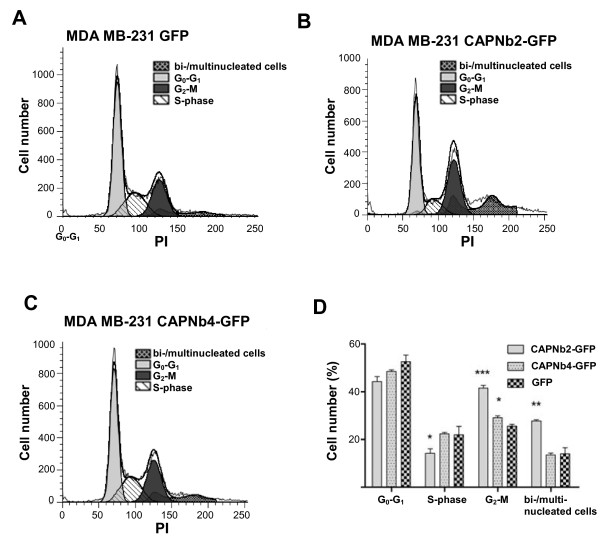
CAPNb2 induces moderate multinucleation. Flow-cytometry profiles. Unlike MDA-MB-231-GFP (A) or MDA-MB-231-CAPNb4 cells (C), MDA-MB-231-CAPNb2 cells (B) harbor a larger proportion of G2/M cells (t test, P = 0.0003, n = 3) and bi/multinucleated cells (t test, P = 0.006; n = 3). Cells in S-phase are significantly decreased (t test, P = 0.01; n = 3). A CAPNb4-triggered increase in G2/M cells is modest but significant (t test, P = 0.04; n = 3). PI, propidium iodide. (D) Histogram summarizing the data shown in (A through C), including statistical analysis (comparison with GFP-expressing control cells). (*p<0.05, **p<0.01 and ***p<0.001).